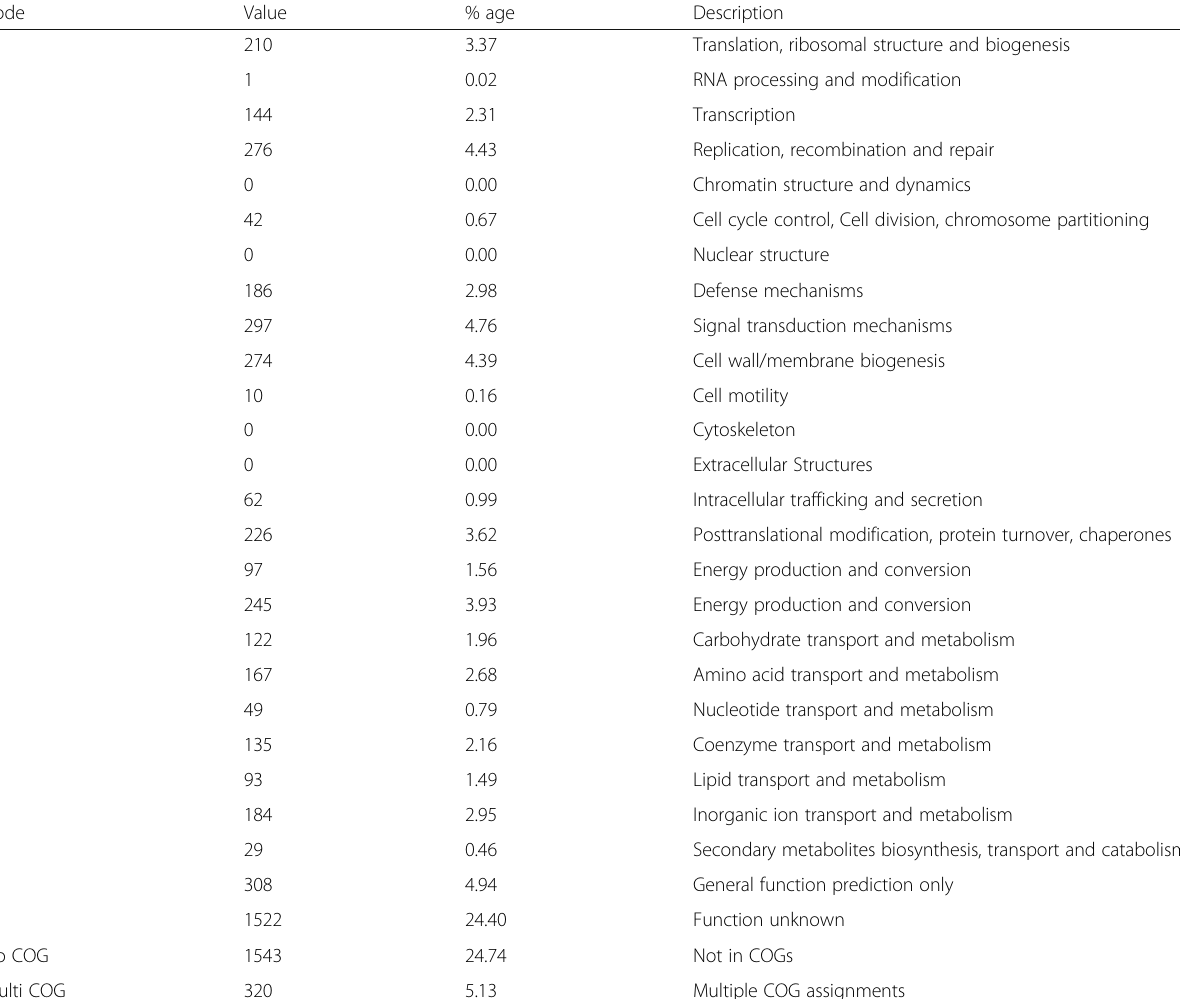
Table 5 Number of genes associated with general COG functional categories of the genome of “ T. syntrophicum ” sp. nov. strain Cad16 T . The percentage is set relative to the total number of protein coding genes in the genome